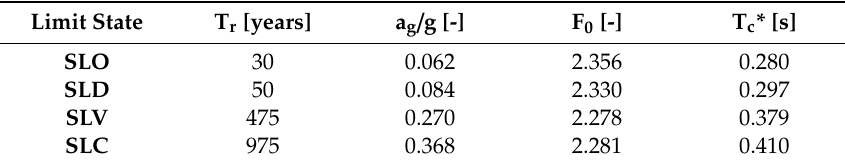
Table 4. As for geotechnical parameters, soil type B and topology type T 1 are considered. Table 4. Parameters to define the elastic acceleration